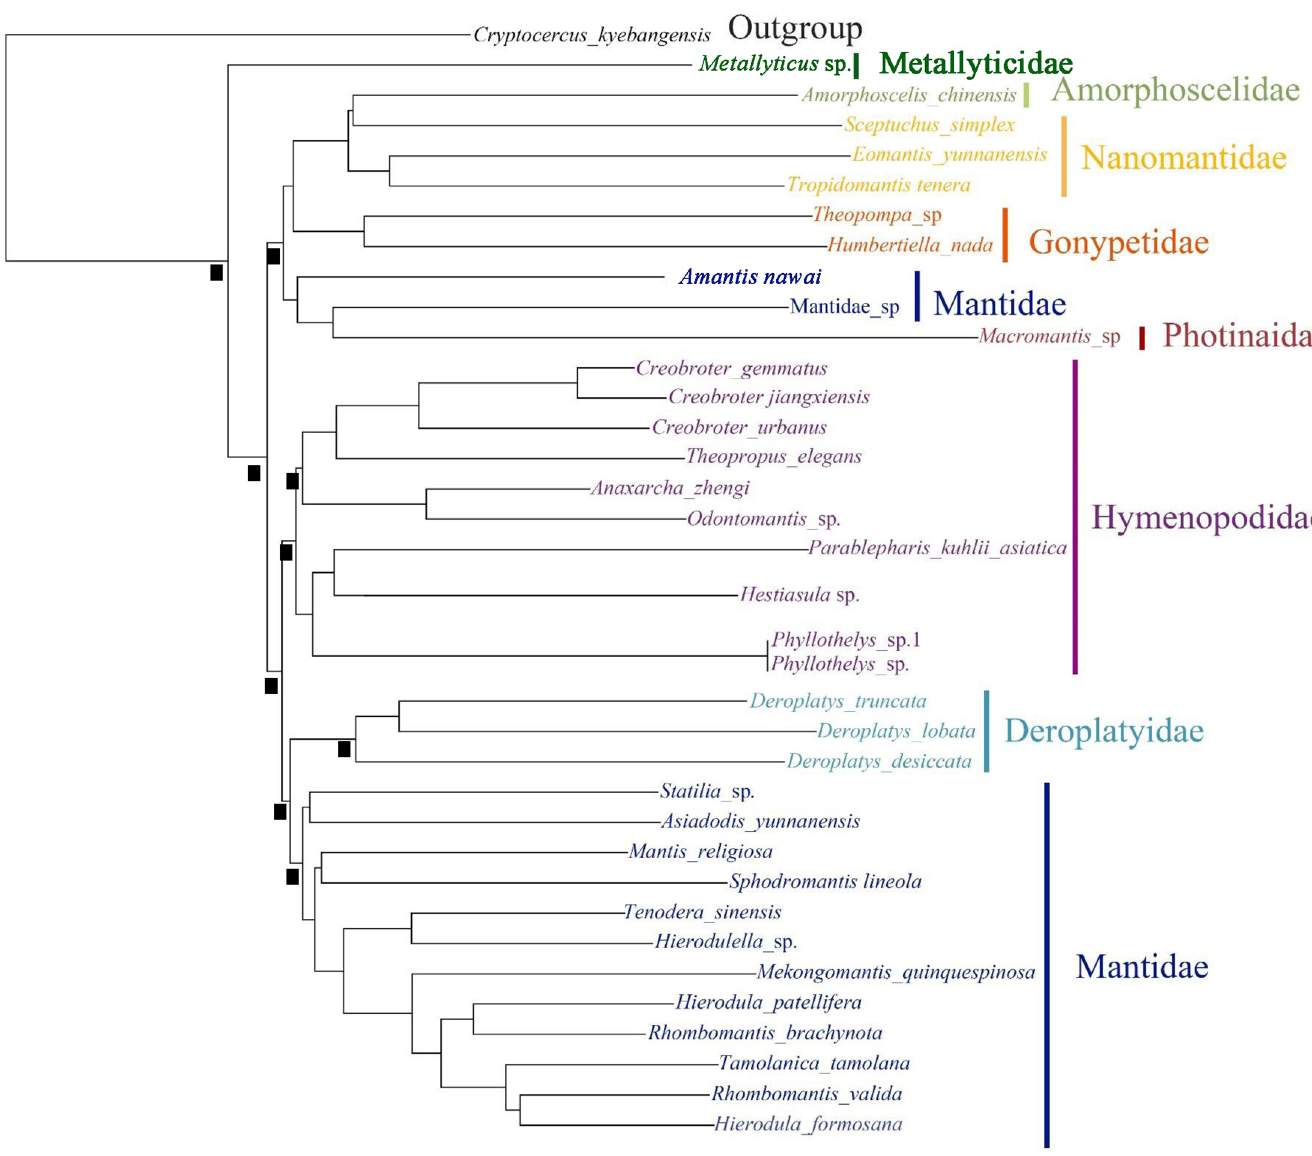
PLOS ONE | https://doi.org/10.1371/journal.pone.0254914 November4,